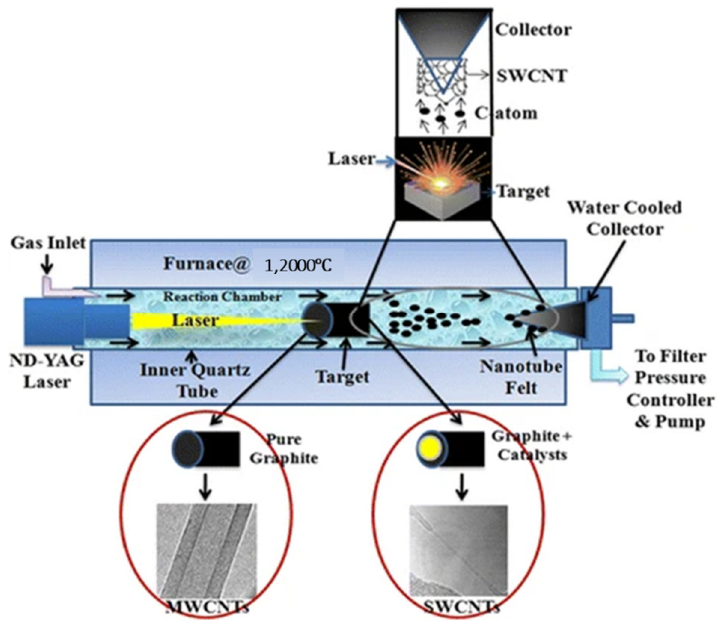
Figure 15. The schematics of a laser ablation setup to produce SWCNTs and MWCNTs [119], open access.